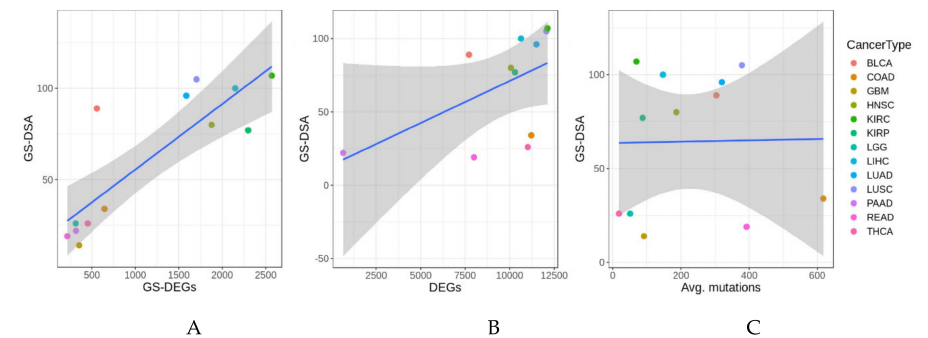
Figure 2. Relationships between. ( A ) gender-specific di ff erential expressed genes (GS-DEG) and gender-specific di ff erential signaling activity (GS-DSA); ( B ) di ff erentially expressed genes between cancer and normal (DEG) and GS-DSA, and ( C ) average mutations (mutation burden) and